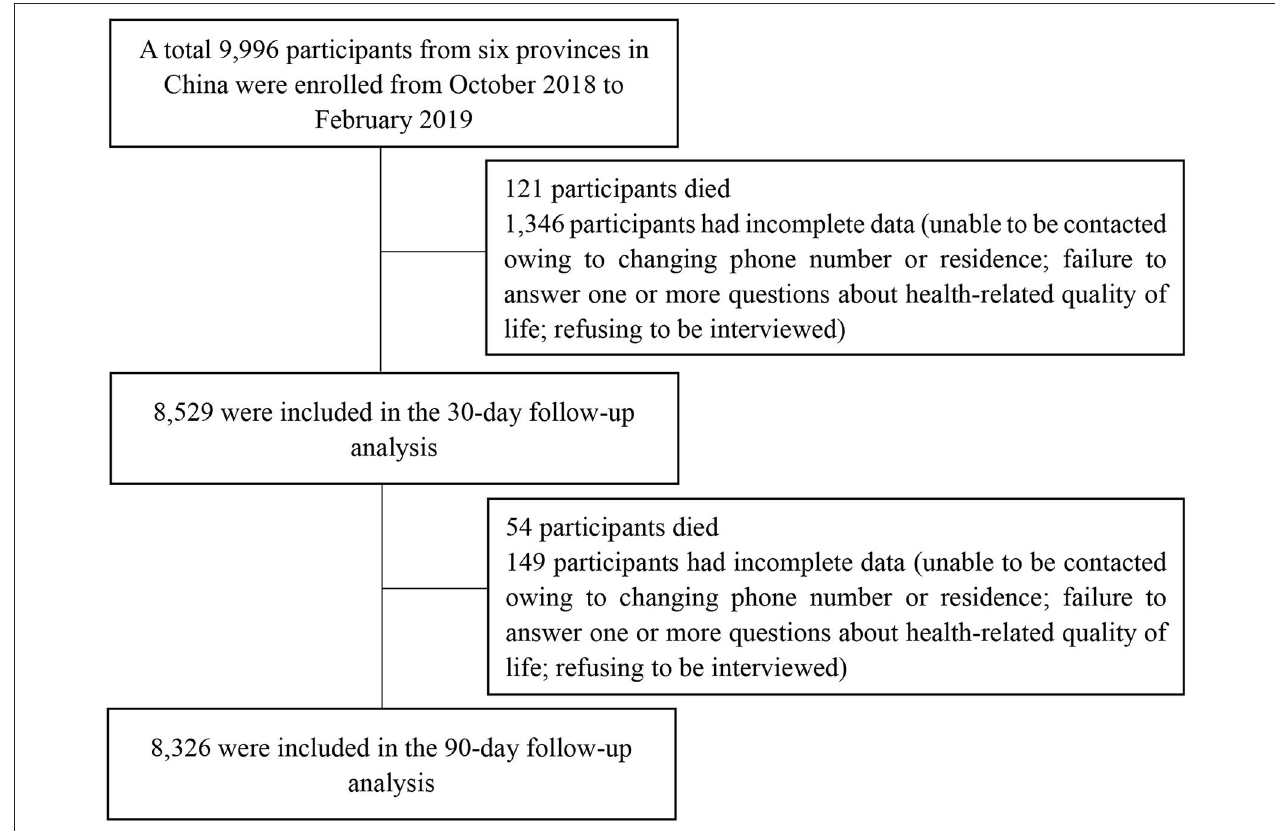
FIGURE 1 | Recruitment and follow-up of